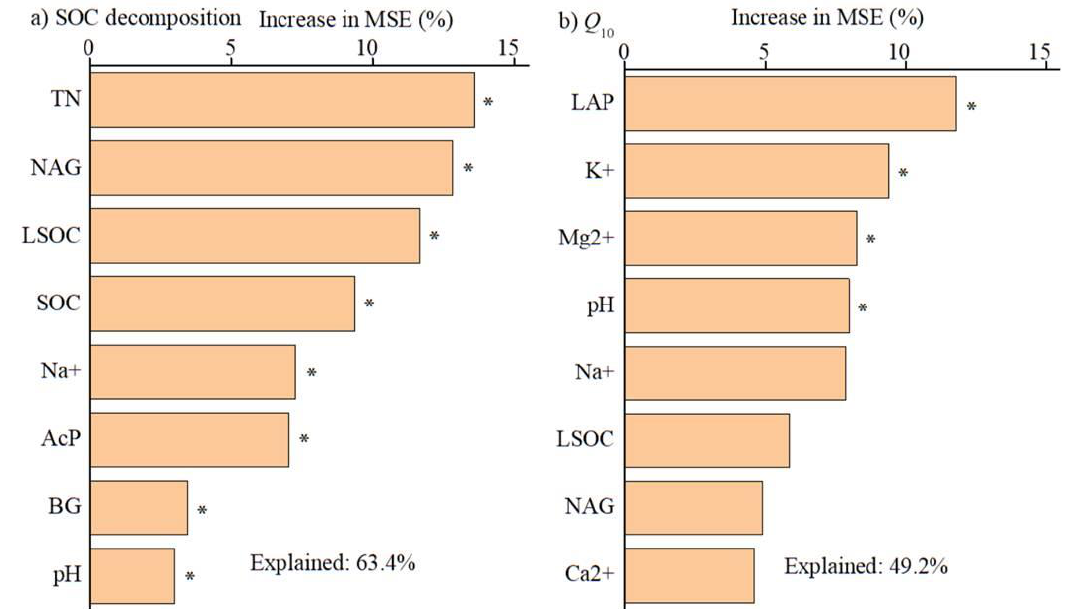
Figure 5. Importance of key factors influencing ( a ) cumulative soil organic carbon decomposition and ( b ) temperature sensitivity ( Q 10 ) based on random forests model analysis. * represents significant effect at p < 0.05. SOC and LSOC denote soil organic C, and labile SOC by KMnO 4 , respectively. K + , Na + , Ca 2+ and Mg 2+ denote exchangeable K, Na, Ca and Mg cations, respectively. TN denotes total nitrogen. BG, NAG, AcP and LAP denote β -1,4-glucosidase, β -N-acetyl-glucosaminidase, acid phosphatase and leucine aminopeptidase, respectively.